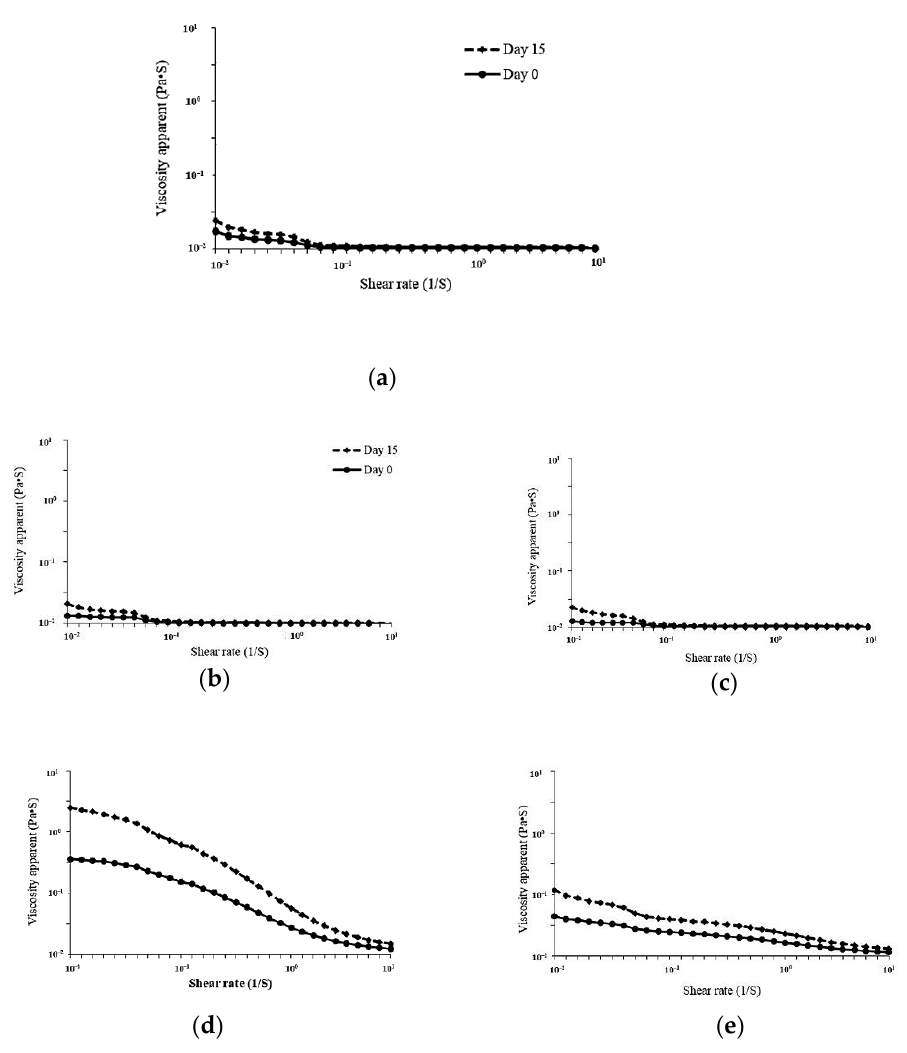
Figure 3. The viscosity of ( a ) guava nectar with sucrose, ( b ) guava nectar with 0.01% neotame, ( c ) guava nectar with 0.01% stevia, ( d ) guava nectar with 0.05% neotam € nd ( e ) guava nectar with 0.05% stevia during storage at 5 °C for 0 and 15 days.